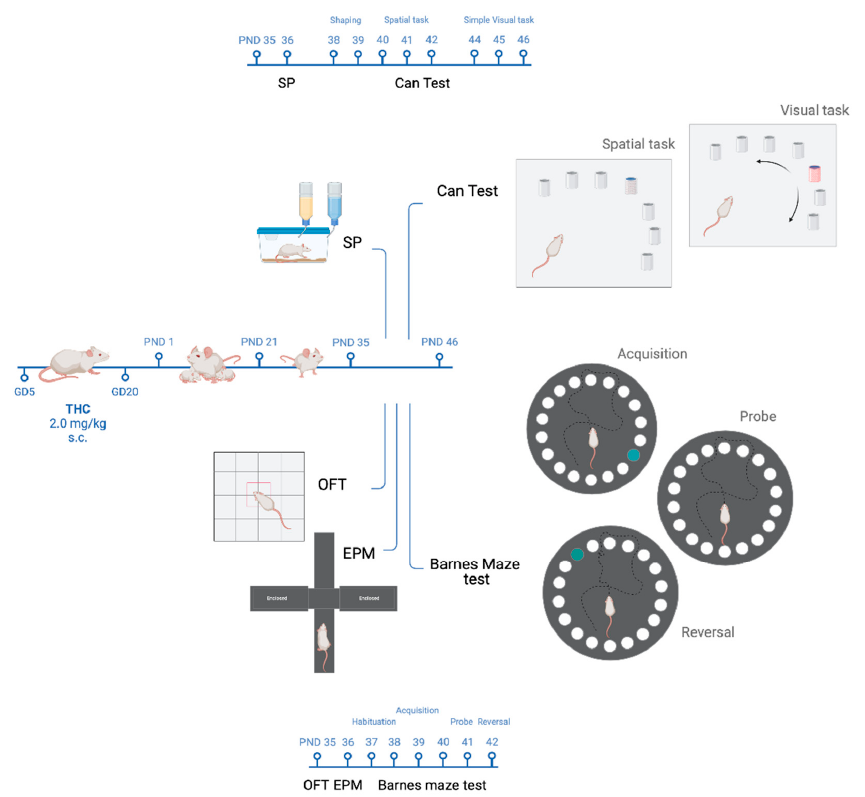
Figure 1. Behavioural procedures. Adolescent male rat offspring prenatally exposed to either vehicle (CTRL) or THC (2 mg/kg; pTHC) underwent behavioural assessments starting from PND 35 to 46. GD, gestational day; PND, postnatal day; s.c., subcutaneous; THC, ∆ 9-tetrahydrocannabinol; OFT, open field test, EPM, elevated plus maze test; SP, sucrose preference test. Created with BioRender.com, https://app.biorender.com (accessed on 23 January 2023).